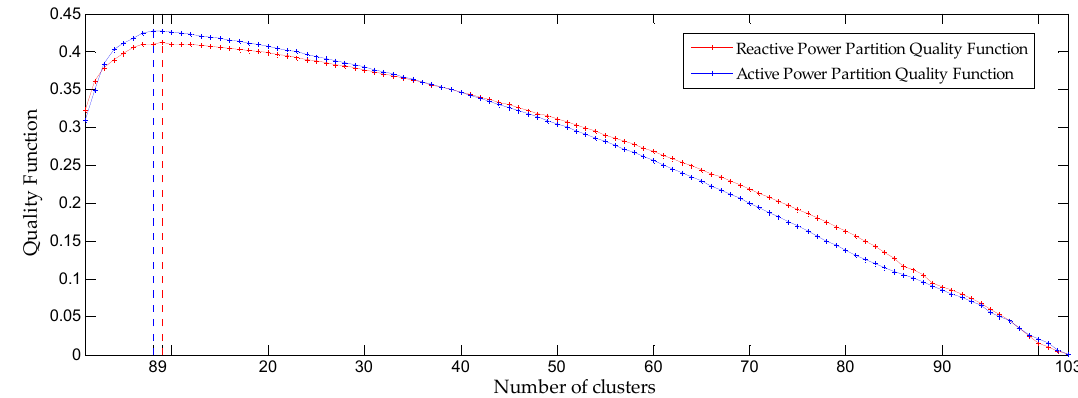
Figure 8. Value of the reactive/active power partition quality function versus the number of sub-networks.